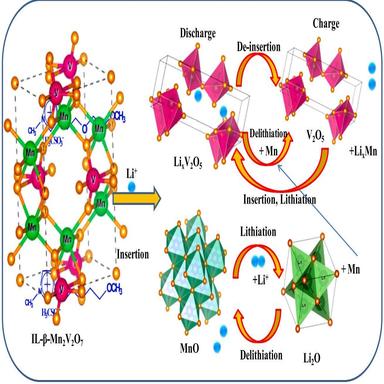
Scheme of the electrochemical reaction process of IL-β-MNV nanorods.